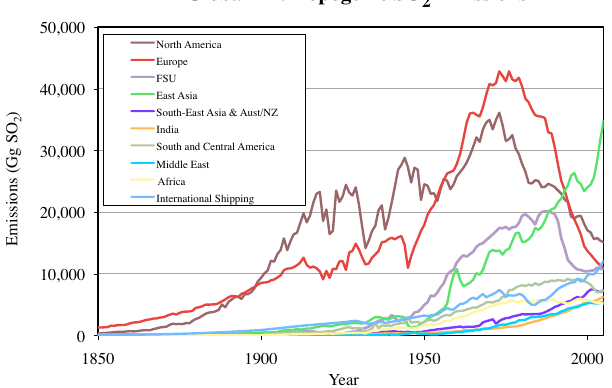
Fig. 6. Global sulfur dioxide emissions by region (North Amer- ica=USA+Canada; East Asia=Japan, China+, and South